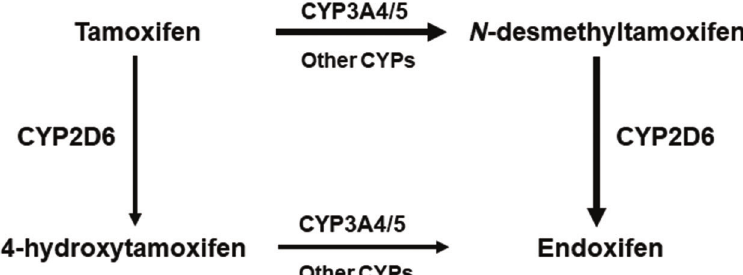
Figure 4 - Metabolic routes of tamoxifen leading to the active metabolites endoxifen and 4-hydroxytamoxifen, showing the major CYP enzyme participating in each step.